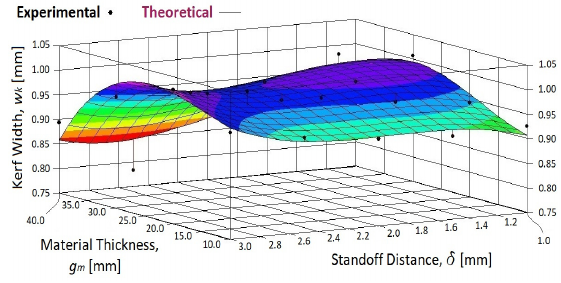
Figure 6. Spatial representation of KW [11]